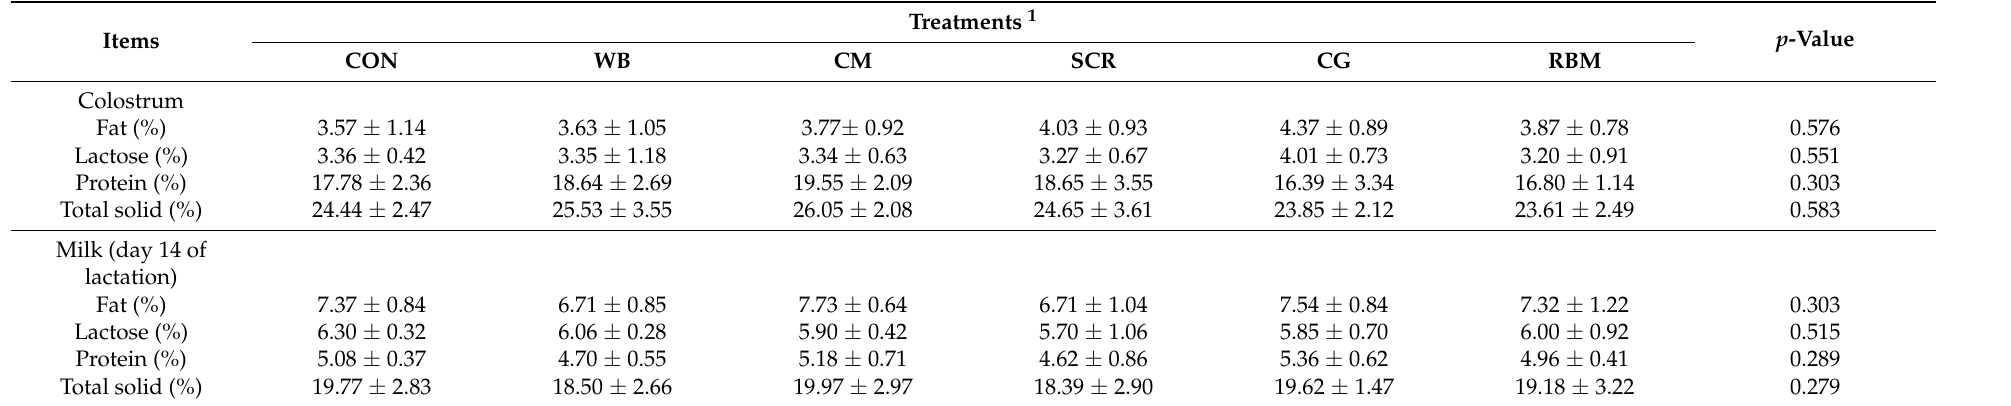
Table 6. Effect of different fiber sources on the composition of colostrum and milk during gestation and lactation.